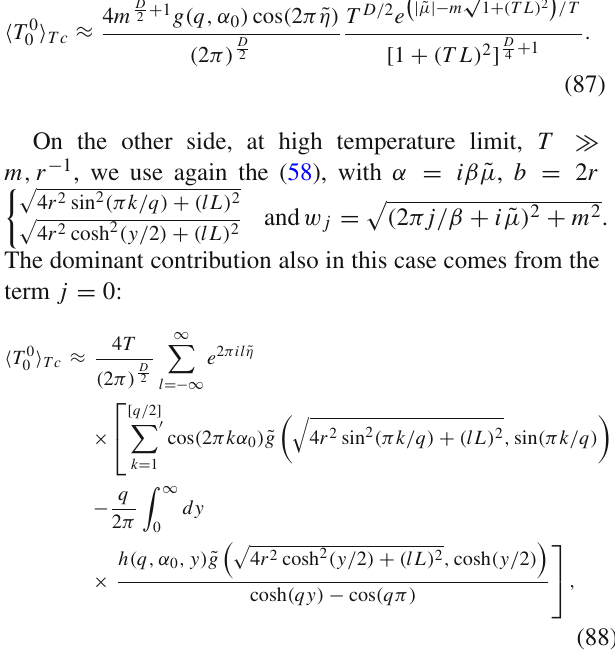
comes from the terms for j = 1 and l = − 1 and for j = 1